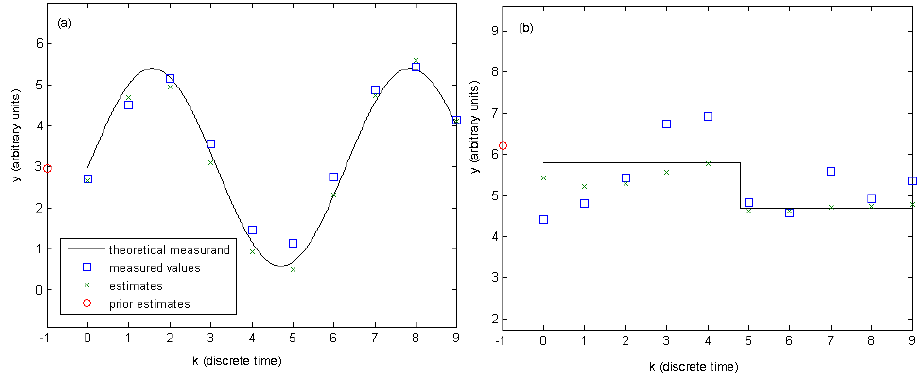
Fig. 3. Cyclic patterns for S 1 (a) and S 2 (b): simulation results.